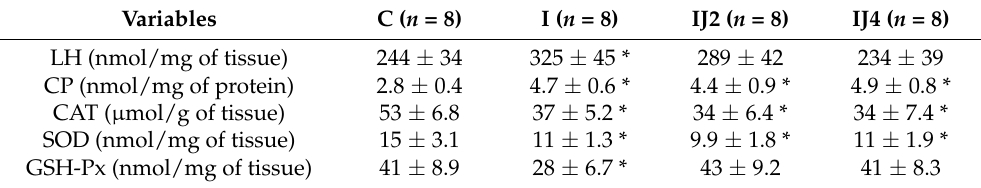
Table 4. Oxidative stress assessment.